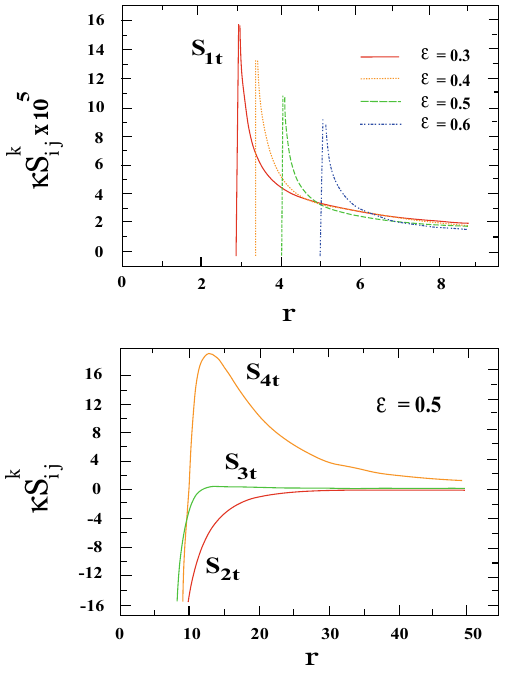
Fig. 9 The AdS contribution of the curvature to the components of the spin current one shown. In the upper panel κη 2 = 0 . 3 ... 0 . 6 for the component s 1 c ( r ) , and in the lower panel the components s 2 c ( r ) , s 3 c ( r ) and s 4 c ( r ) are shown for the same values of κη